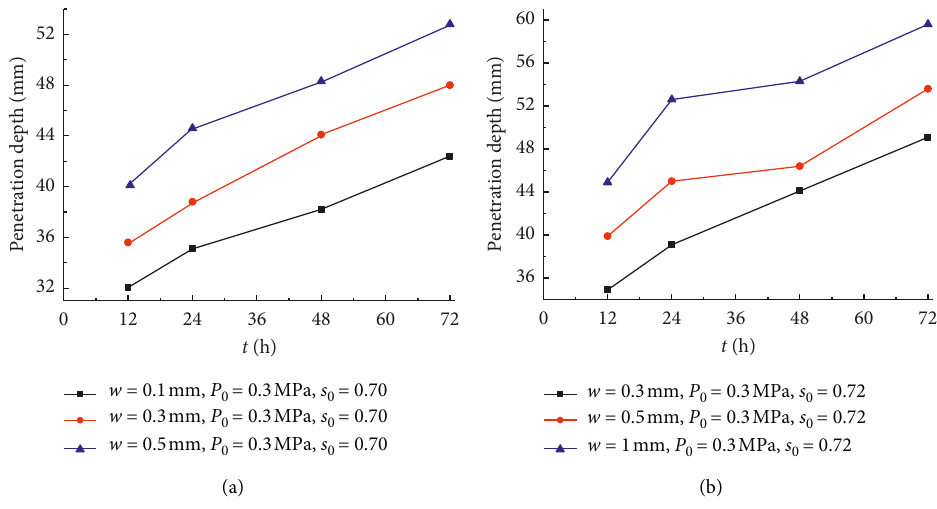
Figure 9: Penetration depth under different crack widths. (a) BI test blocks. (b) BII test